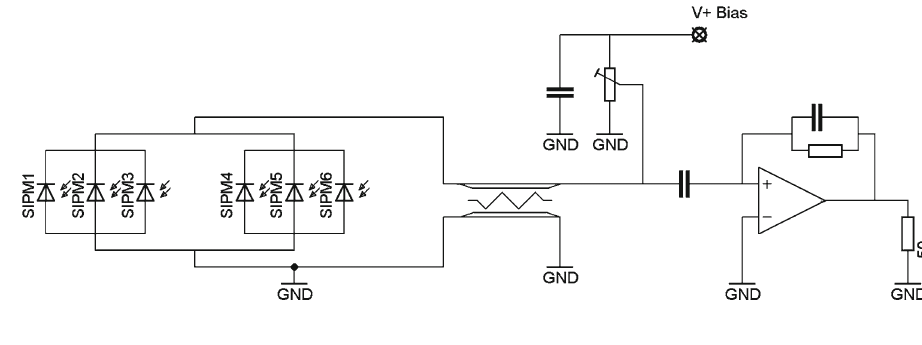
Fig. 17 Circuit diagram of the SiPM readout. Only one channel is shown with six SiPMs in parallel which corresponds to an array of 54 mm 2 . The cable separating the SiPMs and the amplifier is about 20 m long. The charge sensitive amplifier is a